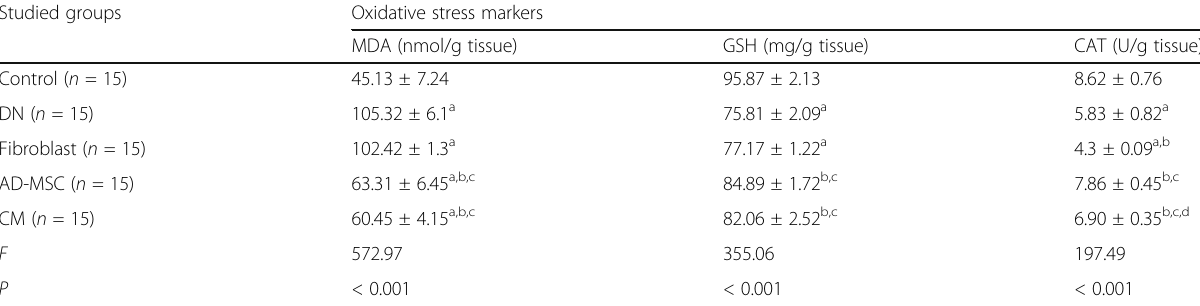
Table 3 Oxidative stress markers in the different studied rats ’ groups Studied groups